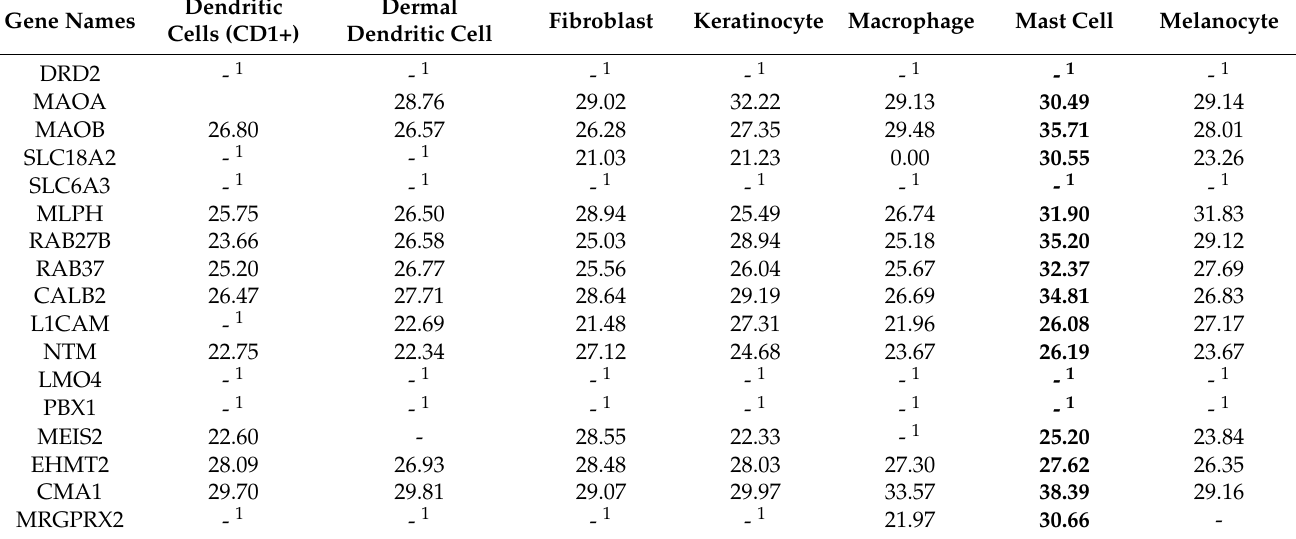
Table 4. Protein abundance of selected proteins in the proteomics study by Dyring-Andersen et al., 2022 [79]. In this study, a spatially resolved quantitative proteome atlas of the different layers and cell types of healthy human skin was created, yielding almost 11,000 proteins, using tissue sections, flow cytometry, and mass spectrophotometry. Protein abundance was represented as log 2 LFQ (untargeted label-free quantitation) score. Higher LFQ values indicate higher expression of the mentioned protein in the indicated samples. MCs are highlighted by bold